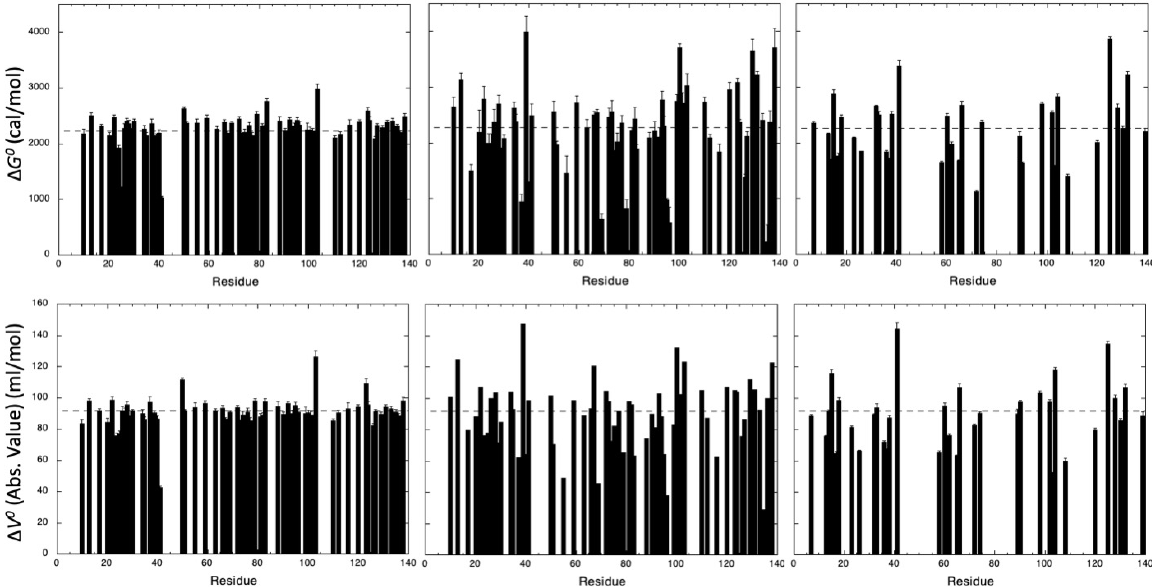
Figure 4. Thermodynamic parameters measured for the unfolding reaction of ∆ +PHS SNase. ∆ G 0 (upper panels) and ∆ V 0 (absolute value, lower panels) obtained from the fit with Equation (1) of the pressure-dependent sigmoidal decrease of the residue cross peak intensities of (from left to right) NH amide groups, C α H α groups, and CH 3 groups. For I, L and V residues, when denaturation curves have been obtained for each of the two cross peaks (corresponding to the two methyl groups), averaged values of ∆ G 0 and ∆ V 0 are displayed. The dashed lines represent the mean values of the measured thermodynamic parameters. The values of ∆ G 0 , ∆ V 0 and also P 1/2 (the half-denaturation pressure) are gathered in Table S1 (Supplementary Materials).